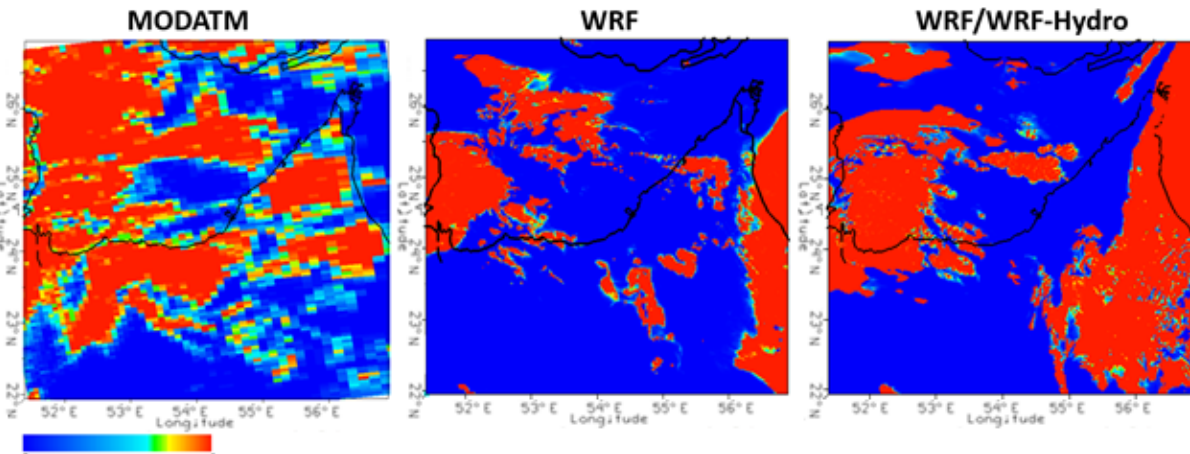
Figure 9. Cumulative cloud fraction retrieved from MODATM and simulated by WRF and WRF–WRF-Hydro for 9 March 2016